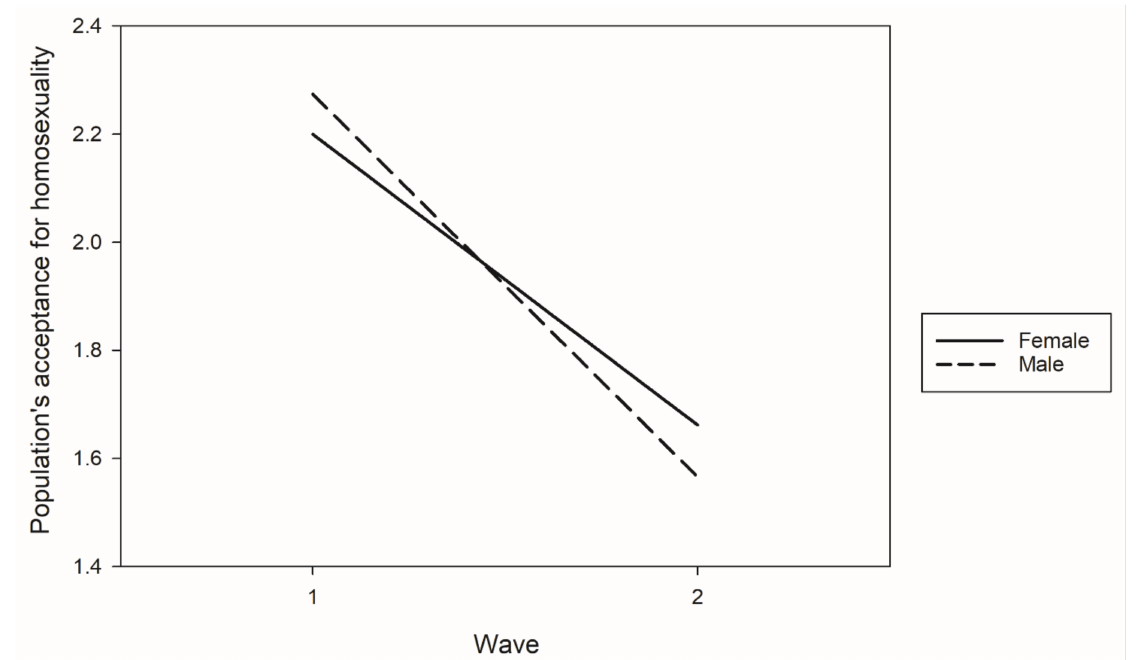
Figure 1. Gender differences in perceived homosexuality acceptance in the general population in the two surveys.